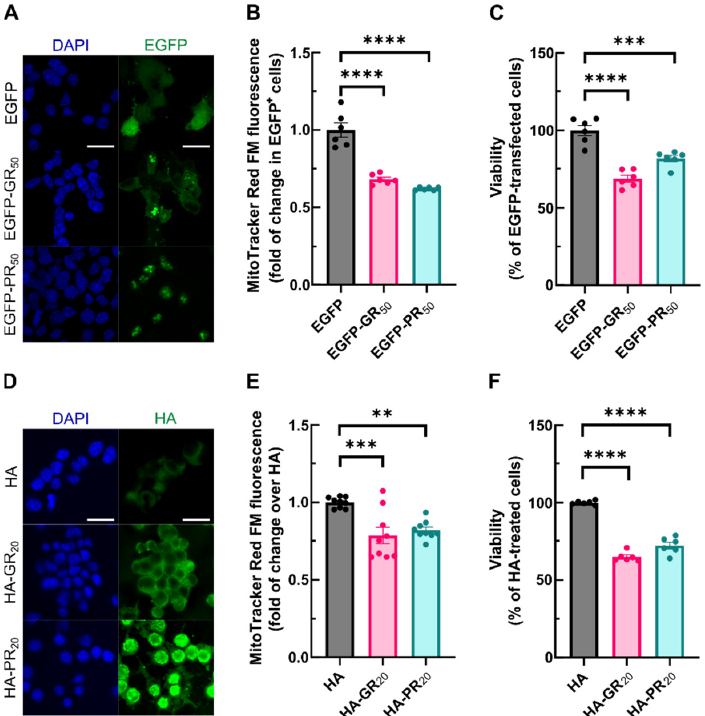
Figure 2. Endogenous and exogenous exposure to poly-GR and poly-PR decrease mitochondrial membrane potential and induce cell death. NSC34 cells were either transiently transfected with EGFP (control), EGFP-GR 50 or EGFP-PR 50 during 48 h or treated with 6 µ M of HA, HA-GR 20 or HA-PR 20 peptides for 6 h (immunofluorescence) or 24 h (flow cytometry and viability assay). ( A , D ) EGFP fluorescence or HA immunofluorescence staining was analyzed by microscopy. Nuclei were counterstained with 4 (cid:48) ,6-diamidino-2-phenylindole (DAPI). Scale bar: 40 µ m. ( B , E ) cells were treated with 0.5 µ M MitoTracker Red FM during 30 min and fluorescence was measured by flow cytometry analysis. Each point depicts the geometric mean of probe fluorescence in cells from that sample (( B ), alive EGFP + cells, ( E ), all alive cells). ( C , F ) viability of the cells was measured using an MTT assay. Bar height indicates the mean of the whole group and error bars indicate the SEM. Statistical analysis was performed with one-way ANOVA. Dunnett’s post-hoc test. **, p < 0.01; ***, p < 0.001; ****, p <